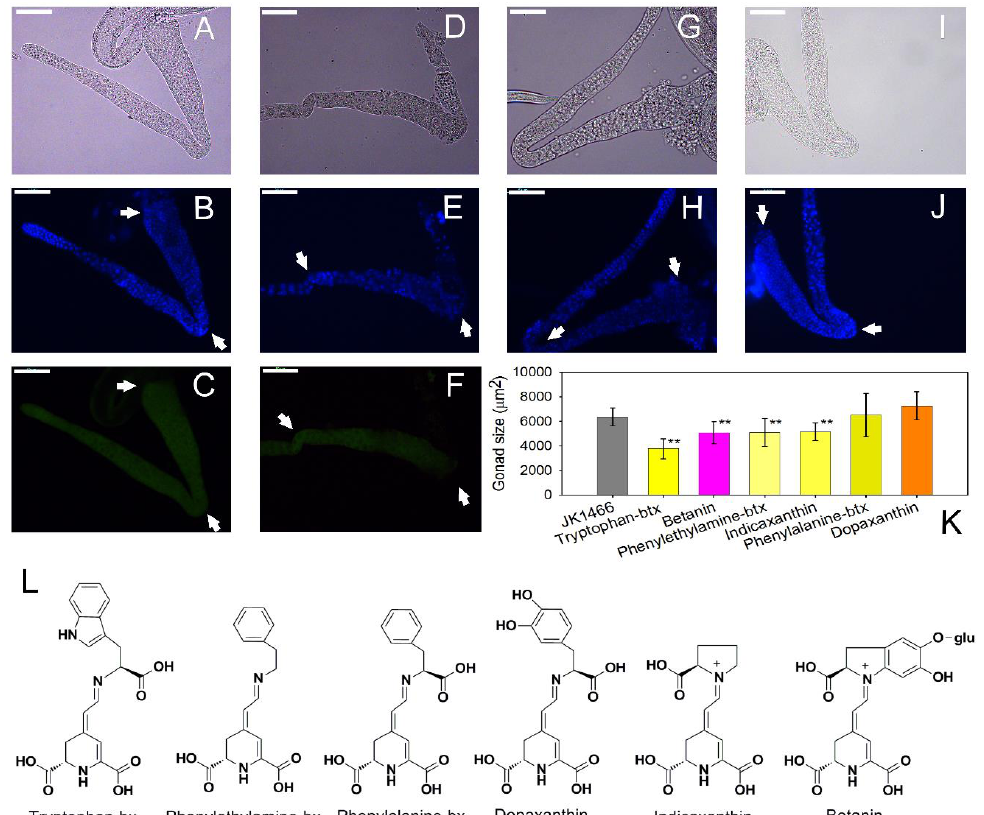
Figure 4. Size and morphology comparison of the gonads of C. elegans gld-1 mutants with and without treatment with pure betalains (25 µ M). Representative images of BF, DAPI-stained and Acridine Orange-stained of dissected gonads from glp-1 (q485) animals treated with pure betalains and without treatment. Scale bar, 50 µ m. Dissected gonads images from gld-1 mutants without treatment (positive control) in bright field ( A ), DAPI ( B ), and Acridine Orange-stained ( C ). Dissected gonads images from gld-1 mutants treated with tryptophan-betaxanthin in BF ( D ), DAPI ( E ), and Acridine Orange-stained ( F ). Dissected gonads images from gld-1 mutants treated with betanin in BF ( G ) and DAPI-stained ( H ), and treated with phenylethylamine-betaxanthin in BF ( I ) and DAPI-stained ( J ). Gonads from loop region to proximal region have been indicated with arrow marks. ( K ) Gonads sizes (mean ± SEM) histograms of gld-1 mutants treated with the pure betalains tryptophan-betaxanthin ( n = 13), betanin ( n = 8), phenylethylamine-betaxanthin ( n = 17), indicaxanthin ( n = 15), phenylalanine-betaxanthin ( n = 14), dopaxanthin ( n = 12) and without treatment (positive control) ( n = 15). Structures for all the pure betalains studied in this work are shown ( L ). glu: glucose; bx: betaxanthin.** indicated p ≤